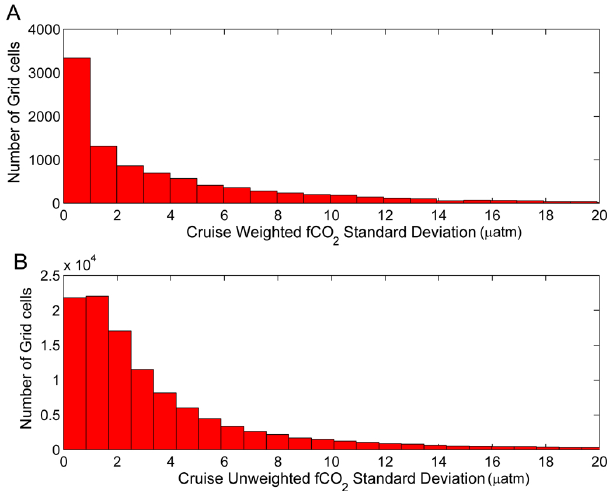
Figure 2. Histogram of all grid cells (1970–2007) with non-zero standard deviations of the (A) cruise-weighted f CO 2 values ( µ atm) and (B) unweighted f CO 2 values ( µ atm).